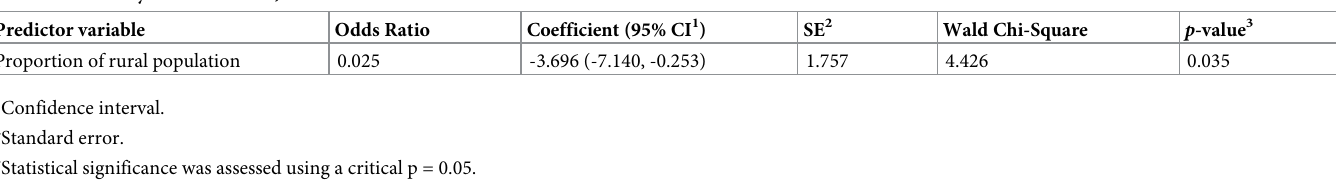
Table 8. Results of the final logistic model showing statistically significant predictor of clusters of Diabetes Self-management Education (DSME) participation rates at the county level in Florida, 2010.